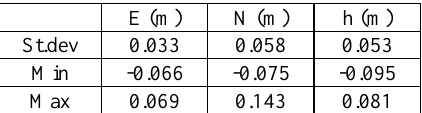
Table 3. Residuals of the photogrammetric coordinates with respect to those topographically surveyed